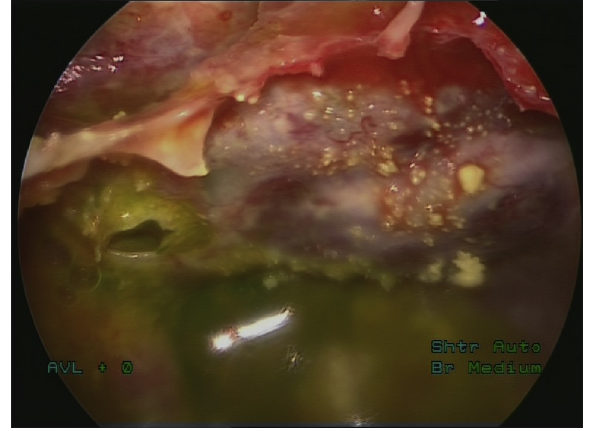
Figure 3 The site of defect after repair of CSF leakage. Results